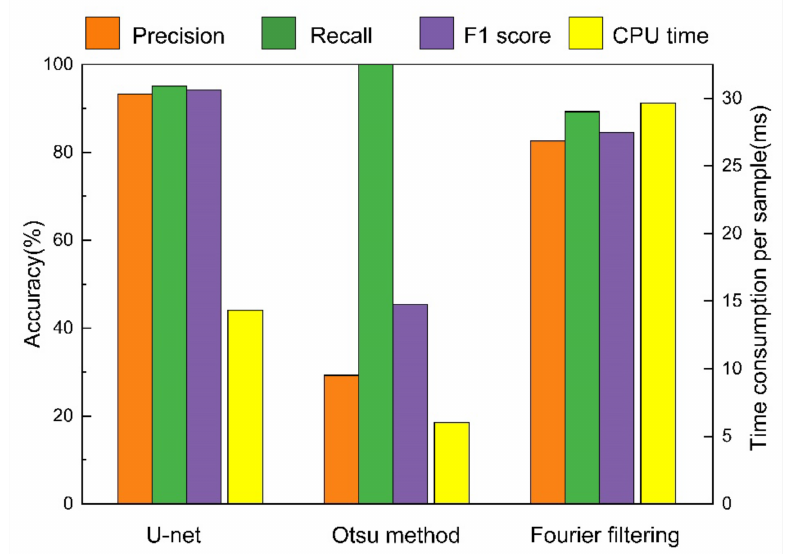
Figure 7. Comparison of performance and time consumption between different